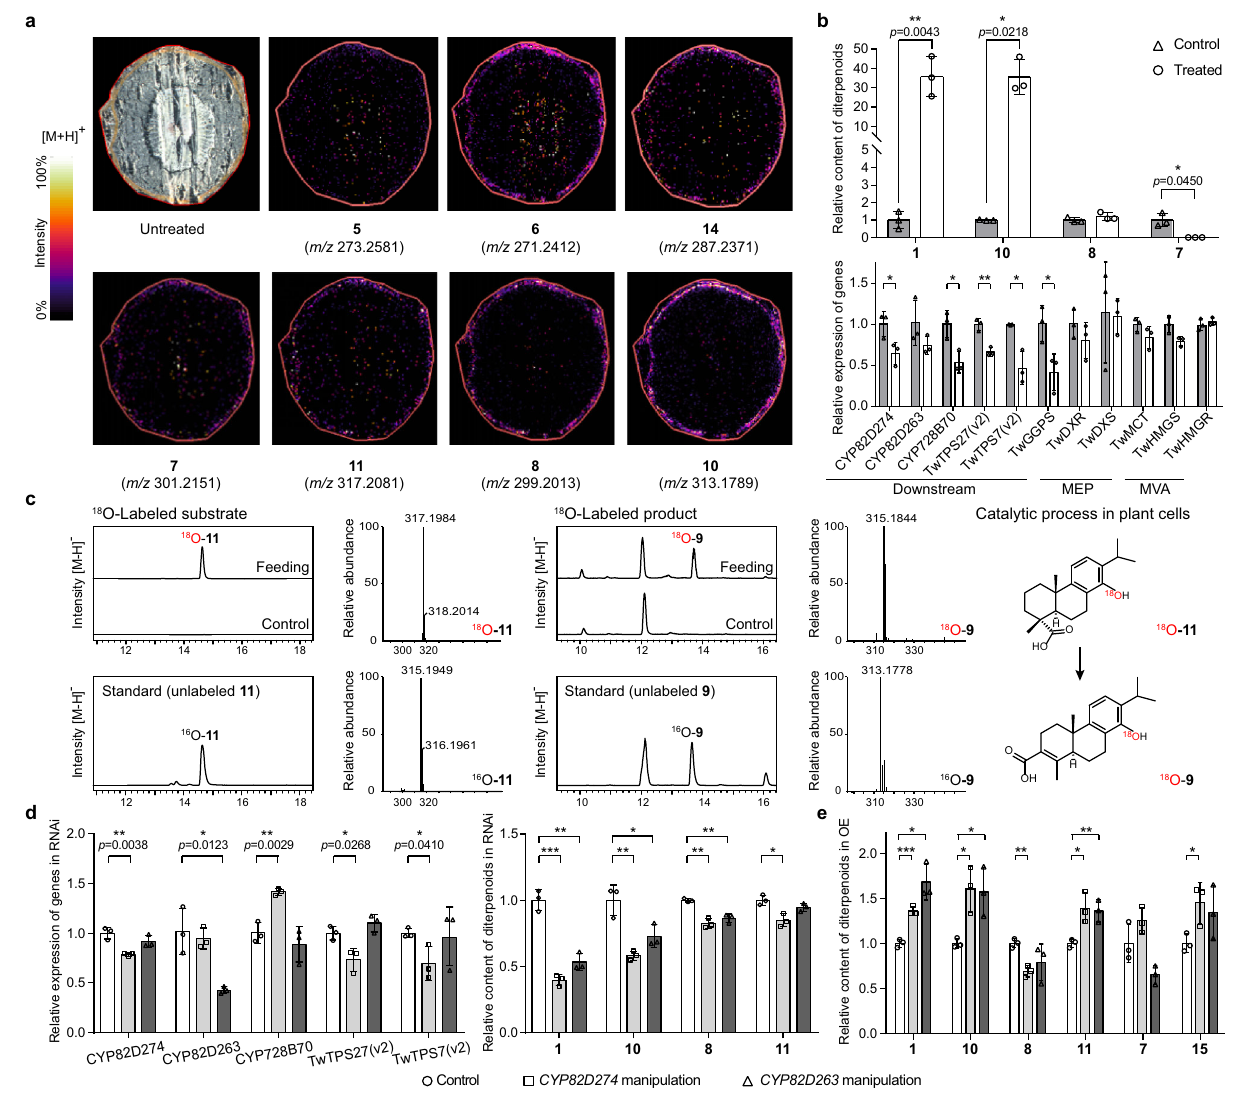
0.00.51.01.52.0 Fig. 4 | Intermediates and genes involved in triptolide biosynthesis. a MALDI- relative gene expression in CYP82D274 and CYP82D263 RNAi cell lines. e Relative content of diterpenoids in CYP82D274- and CYP82D263 -overexpressing cell lines. MSIanalysisofthedistributionoftriptolideintermediatesin T.wilfordii roottissue. The cell lines bombarded with corresponding empty vectors served as controls in DHB was used as a matrix for metabolite imaging in the positive ion mode. The d and e , and signi fi cant differences ( P -values) in metabolites between the groups colors represent the intensity percentage, and each image is independent. b Relativecontentofditerpenoidsandrelativequanti fi cationofgeneexpressionin areshowninSupplementaryData2and3. b , d , e Therelativequanti fi cationofeach metabolite was calculated by dividing each sample by the average content of the 14-hydroxy-dehydroabietic acid ( 11 )-fedcell lines. Cells that were not fed 11 served control group. The relative expression of genes was determined by the 2 − △△ Ct as a negative control. P -values of genes with signi fi cant differences in expression method. EFL α was designated as the housekeeping gene, and the corresponding between groups were 0.0375, 0.0178, 0.0031, 0.0448, and 0.0294 in that order. c Metabolite analysis of 18 O-labeled 11 -treated cell samples. 18 O- 11 was fed to T. control group was assigned as the reference sample. Data are presented as mean values±SD ( n =3 biologically independent replicates). *** P <0.001, ** P <0.01 wilfordii suspension cells that inhibited the biosynthesis of precursors, and wild- type(WT)and unlabeled 11 -treatedcellswereused asnegativecontrols. 18 O- 11 was converted into 18 O-triptinin B ( 9 ) in plant cells, and the mass spectra of labeled versus unlabeledmetabolites are provided. d Relative content of diterpenoids and 0.99±0.17 μ Mand8.42 ± 1.89 μ M,respectively,attheoptimalreaction time (Fig. 3c and Supplementary Fig. 10a). These steady-state kinetic parameters indicated that CYP82D274 was signi fi cantly superior to CYP82D263 in terms of substrate af fi nity and catalytic ef fi cacy. CYP82D274 and CYP82D263 are involved in triptolide (II) and transformed them into suspension cells by plasmid biosynthesis bombardment 25 . The electrophoretic bands of the vector-speci fi c To further investigate the de fi nitive role of CYP82D274 and CYP82D263 fragment indicated successful transformation (Supplementary in 1 biosynthesis, RNA interference (RNAi) was utilized to knock down Fig.11a),anddetectionof theexpressionof CYP82D274 and CYP82D263 the expression of these two genes in T . wilfordii suspension cells. All showed that they were targeted for disruption as expected (Fig. 4d).